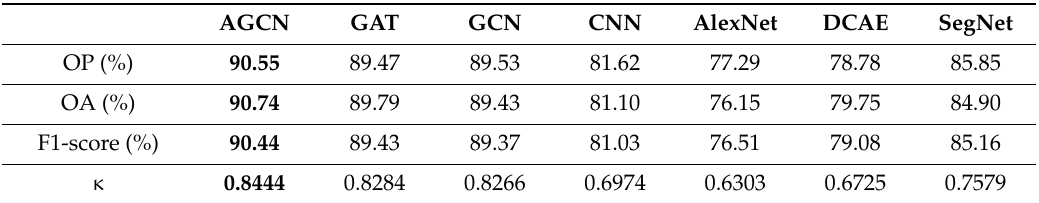
Table 3. Comparison of the overall segmentation performance with six state-of-the-art methods. GAT, Graph Attention Network. AGCN